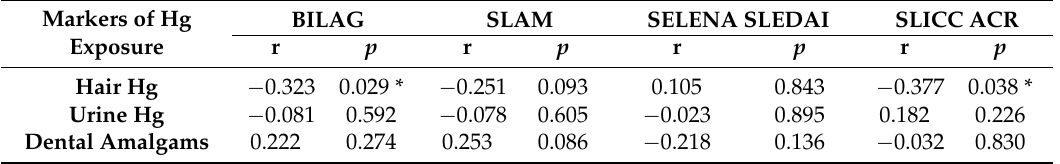
Table 2. Correlation between markers of Hg exposure and disease activity and damage in SLE ( n = 52). Markers of Hg